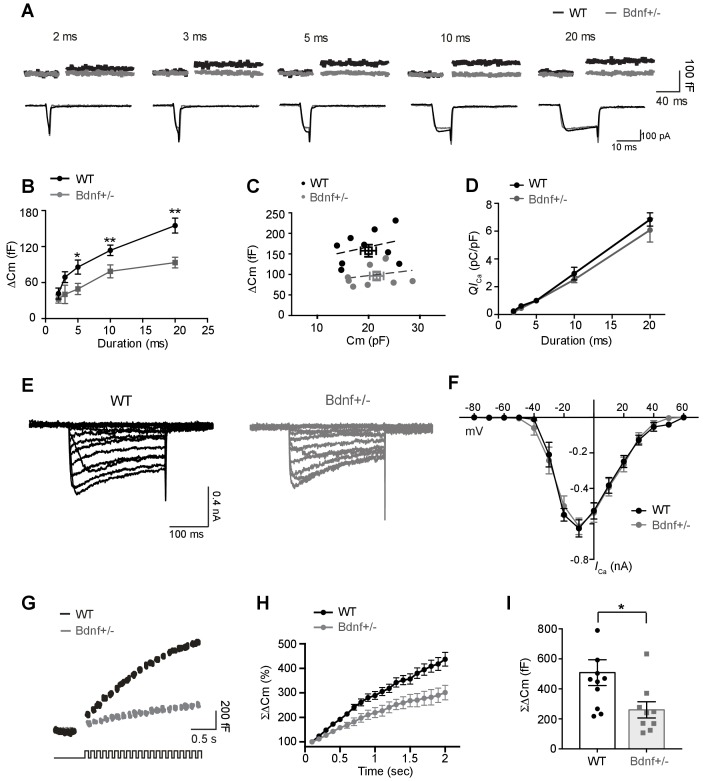
Exocytosis of vesicular glutamate is decreased at the calyx terminals in Bdnf+/– mice.(A) Representative traces of membrane capacitance (Cm; top) and Ca2+ current (ICa; middle) induced by 2-, 3-, 5-, 10-, and 20 ms depolarization (bottom) from P9–13 calyx terminals in WT (black) and Bdnf+/– (gray) mice. Capacitance within 50 ms after depolarization is not shown to avoid artifacts. (B) Summary of capacitance changes (ΔCm), which are plotted against the depolarization duration in WT and Bdnf+/– mice. (C) Scatter plot: ΔCm (elicited by 20 ms depolarization)is plotted against the corresponding resting Cm for each calyx terminal. The squares indicate the mean value. The black and gray lines are linearly fit from each dot for WT and Bdnf+/– mice, respectively. (D) Summary of Ca2+ current charge (QICa), which is plotted against the depolarization duration for each genotype. (E) Representative traces of ICa induced by a 200 ms step-like depolarization (from –80 to 60 mV, Δ10 mV) in WT (black; n = 5) and Bdnf+/– (gray; n = 5) mice. (F) The I–V relationship for voltage-activated Ca2+ channels at the calyx terminal for each genotype is also shown. (G) Examples of Cm (top) induced by the train of 20 depolarizing pulses (10 ms, 10 Hz; bottom) from –80 to 0 mV in WT (black; n = 11) and Bdnf+/– (gray; n = 9) mice. (H) Summary of the normalized accumulated capacitance jump (ΣΔCm) relative to the stimulation time for each genotype. Data were normalized relative to the capacitance jump induced by the first 10 ms depolarization. (I) Summary of the ΣΔCm after the train of 20 depolarizing pulses (at 2 s) in each genotype. Data are shown as the mean ± s.e.m. *p<0.05; **p<0.01 (unpaired t-test).